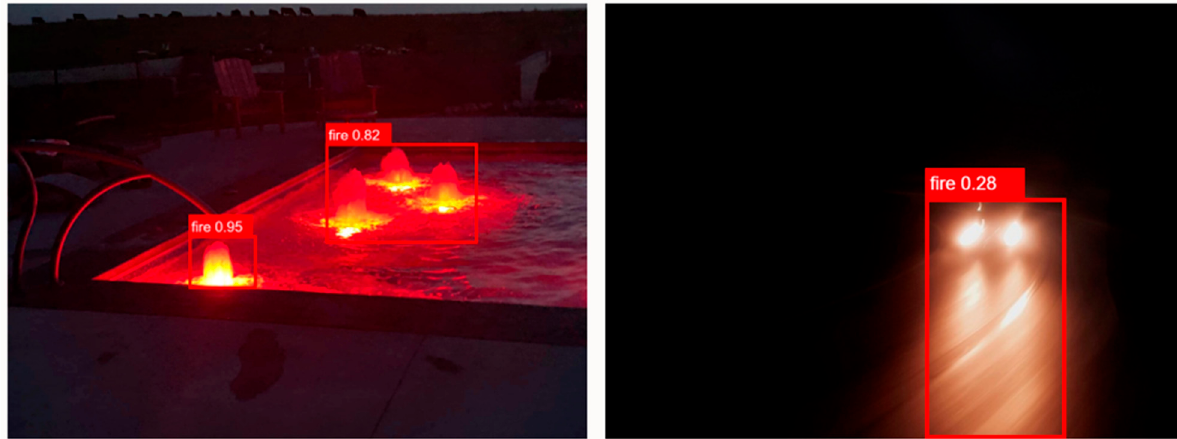
Figure 11. Limitation results for non- fi re images at nigh tt ime.